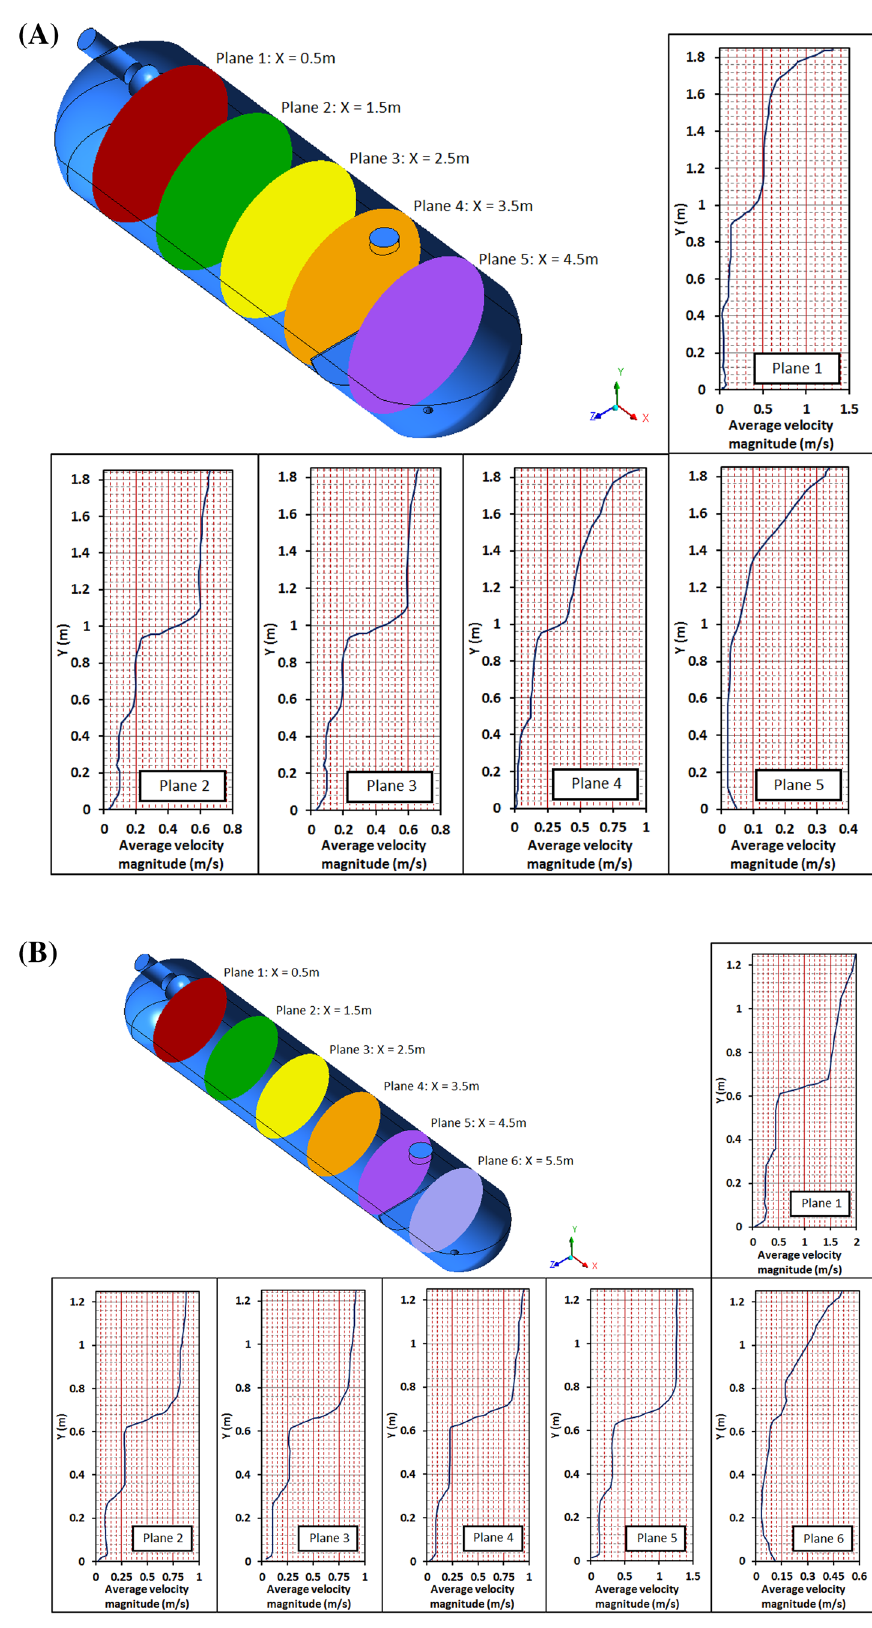
Fig. 17 Simulated average velocity at different vertical planes inside vessels 3 ( a ) and 5 ( b